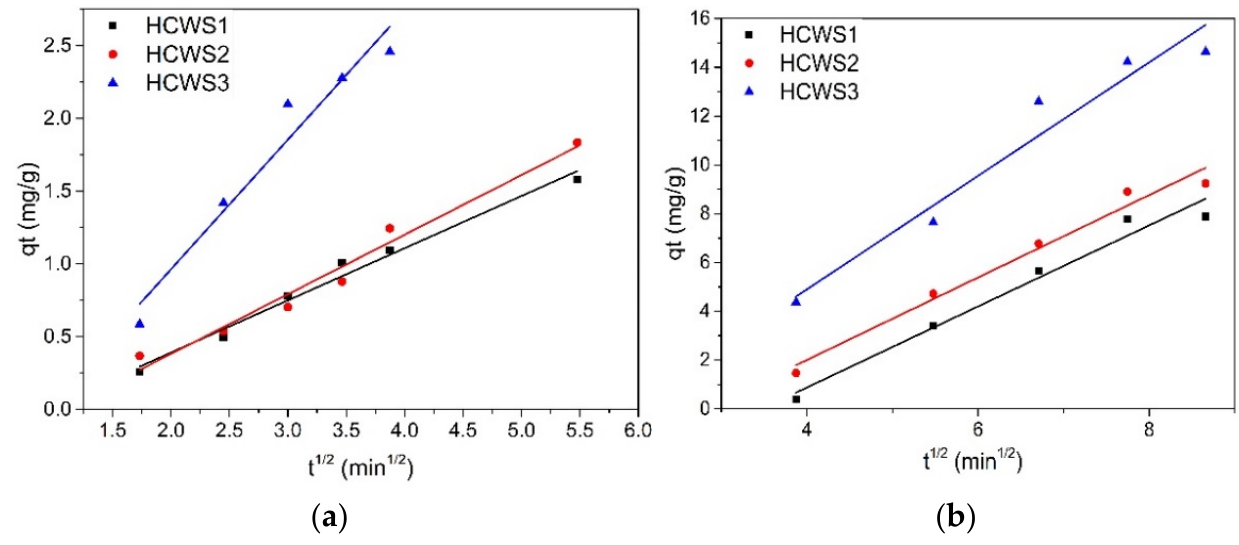
Figure 7. Weber–Morris intraparticle diffusion model for HCWS eco-materials, ( a ) MB; ( b ) PRM.